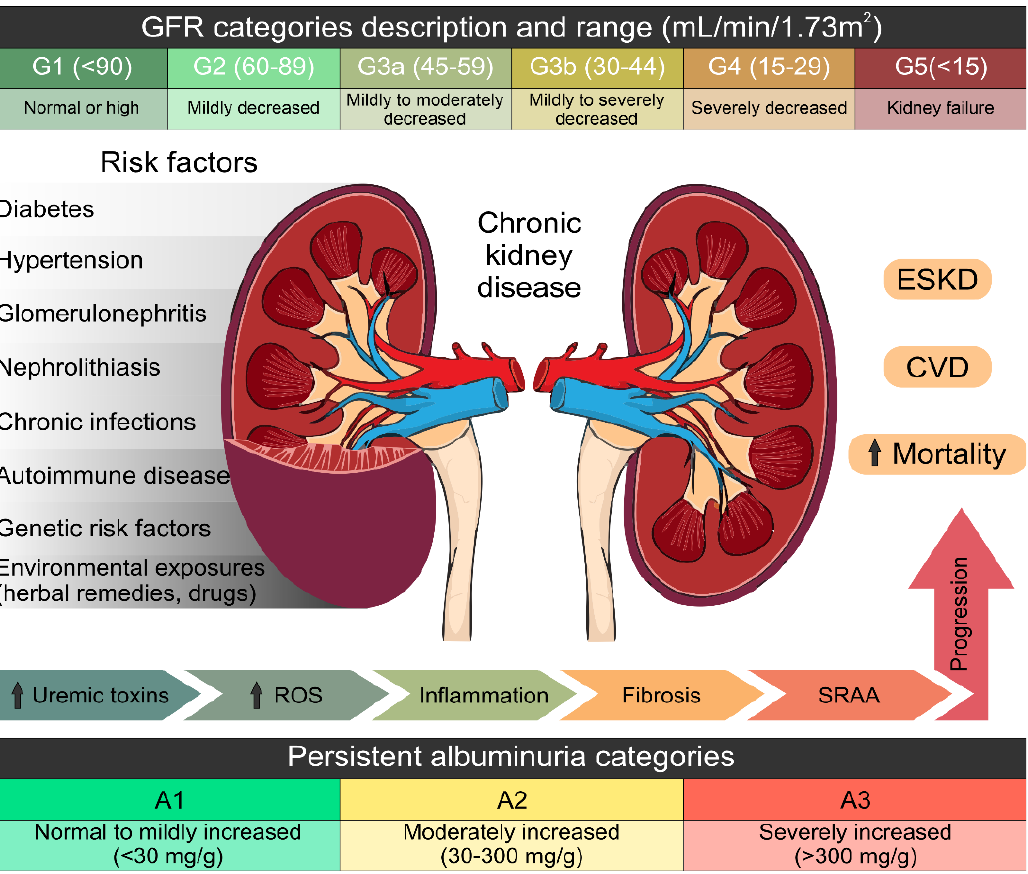
Figure 2. Causes, definition and prognosis of chronic kidney disease classed by glomerular filtration rate and albuminuria. Categories are grouped by risk of progression, defined by a decline in GFR category. Adapted from the Kidney Disease: Improving Global Outcomes (KDIGO 2012) categories of the National Kidney Foundation (NFK). ESKD, end-stage kidney disease; CVD, cardiovascular disease; CKD, chronic kidney disease; GFR, glomerular filtration rate. Some elements of this figure were taken from the Mind the Graph platform, available at www.mindthegraph.com. (Last date of access; Septem- ber 30, 2021).